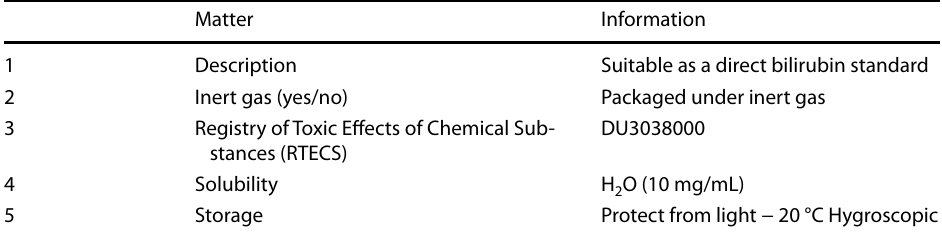
Table 1 The safety data sheet (SDS) for direct bilirubin